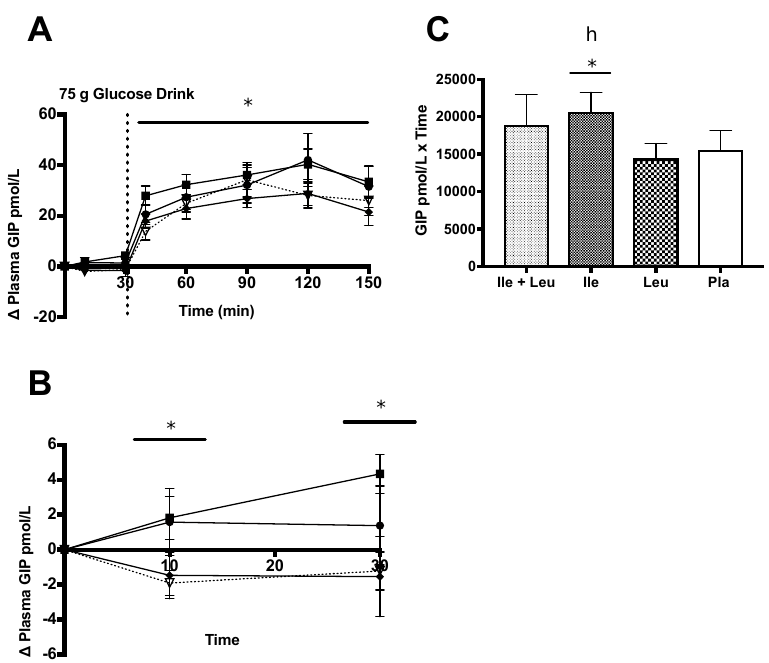
Figure 7. Plasma GIP Total (pmol/L) (mean ± SEM) comparing Ile + Leu, Ile, Leu, and Pla. ( A ; 0 – 150 min) an interaction between time × treatment ( p = 0.007), main effect of treatment ( p = 0.01) and post hoc Ile vs. Leu ( p = 0.02). ( * ) Simple time effect differences at 40 min Ile vs. Leu ( p = 0.004) and Ile vs. Pla ( p = 0.0001); 60 min Ile vs. Leu ( p = 0.009); 90 min Ile vs. Leu ( p = 0.009); 120 min Ile + Leu vs. Leu ( p ≤ 0.0001) and Pla ( p ≤ 0.0001), Ile vs. Leu ( p = 0.0008) and Pla ( p = 0.0003); 150 min Ile + Leu vs. Leu ( p = 0.004) and Ile vs. Leu ( p = 0.0005). ( B ; 0 – 30 min) A interaction between time and treatment ( p = 0.03) and main treatment effect was found Ile vs. Leu ( p = 0.04) and Pla ( p = 0.04). ( * ) Simple effect differences were found at 10 min Ile + Leu vs. Pla ( p = 0.04) and Ile vs. Pla ( p = 0.02); at 30 min Ile vs. Leu ( p = 0.0002) and Ile vs. Pla ( p = 0.0004). ( C ; iAUC) Plasma GIP Total (pmol/L × time): ( η ; * ) main treatment effect ( p = 0.04); Ile vs. Leu ( p = 0.03) and Ile vs. Pla ( p = 0.008).